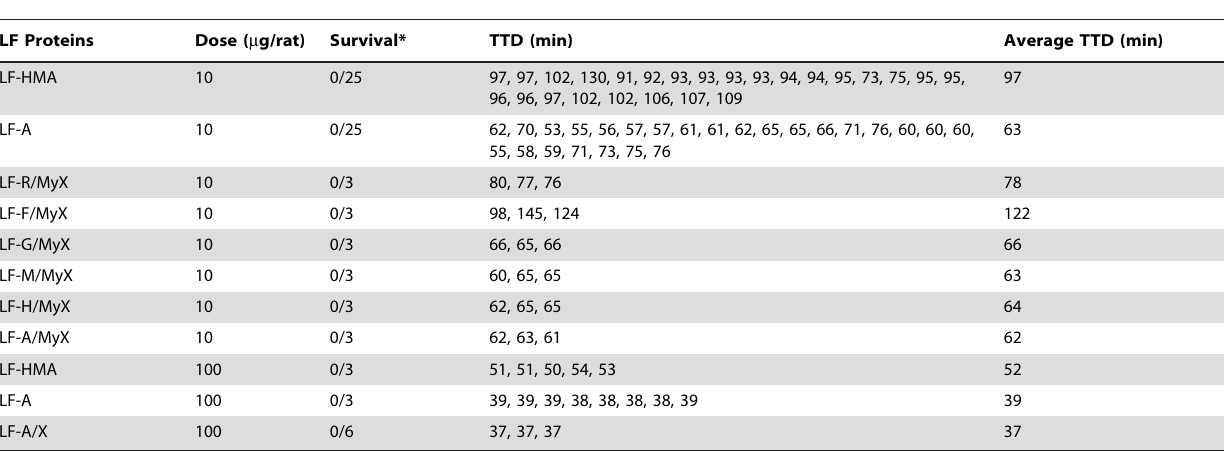
Table 2. Toxicity of LF proteins in